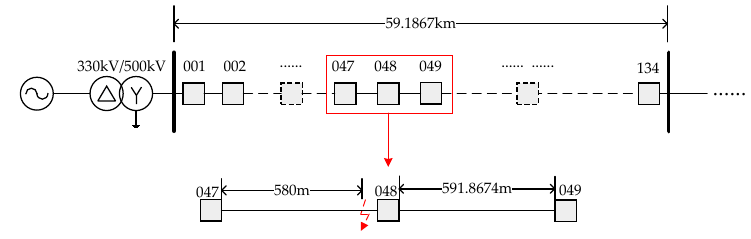
Figure 9. Schematic diagram of the 500 kV transmission line in terms of electrical distance.